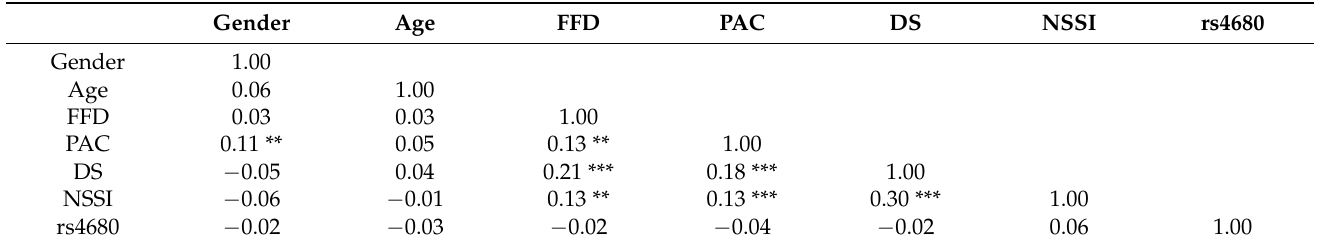
Table 1. Correlations between research variables.